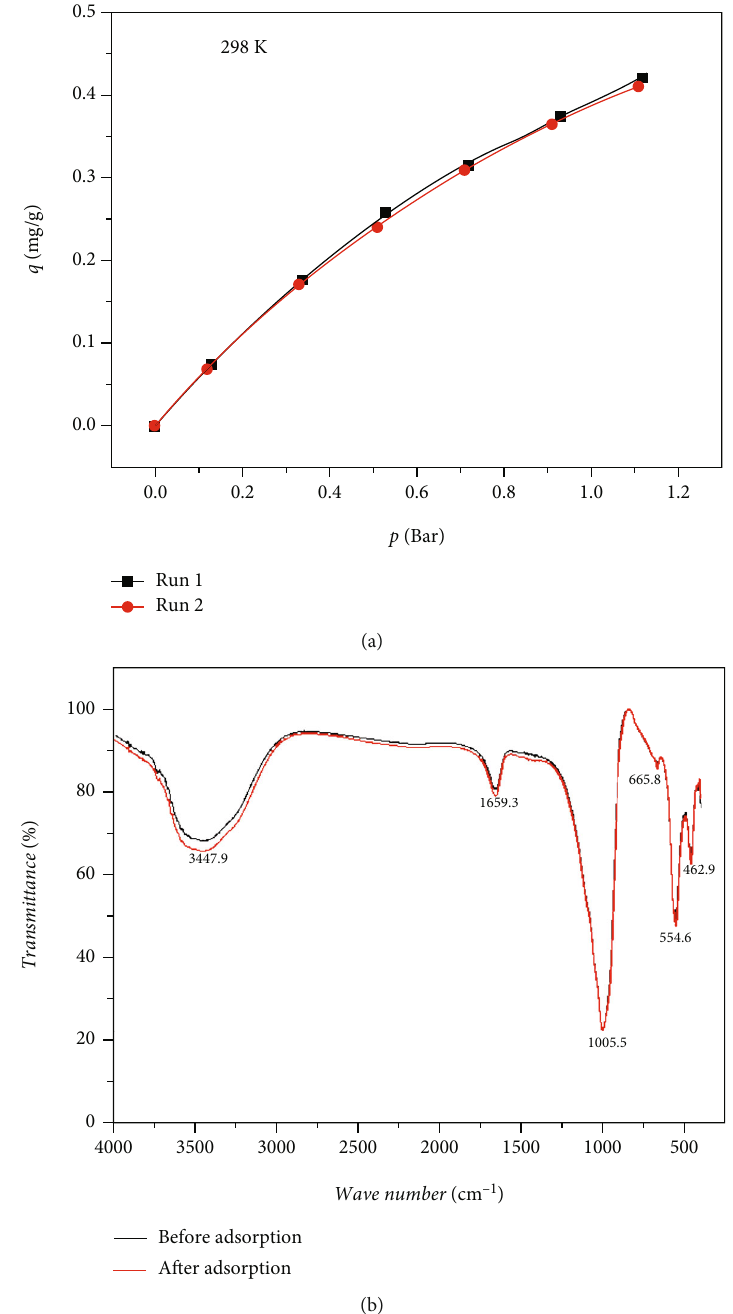
Figure 8: (a) Repeatability experiments of HF on zeolite 3A at 298K. (b) IR spectra of the zeolite 3A before and after HF